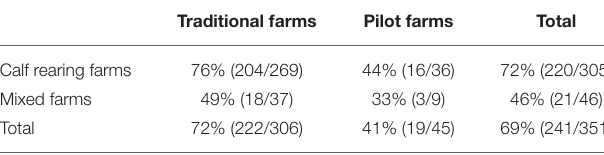
TABLE 1 | Proportions of seropositive animals in each type of farm. Traditional